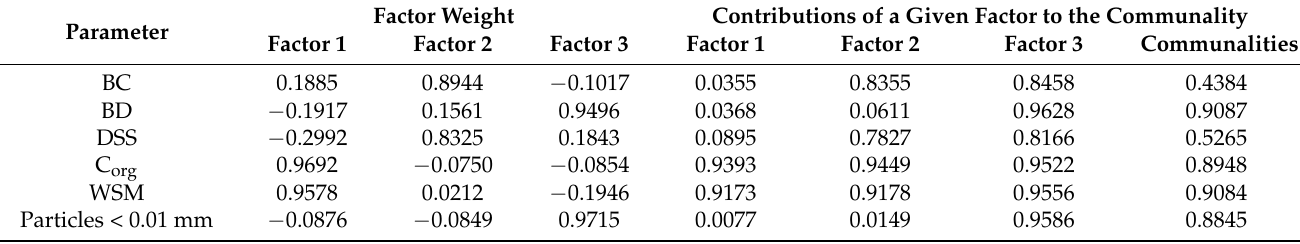
Table 1. Factor weights and contributions of a given factor to the communality for individual traits after rotation of varimax normalized soil quality parameters in the area of